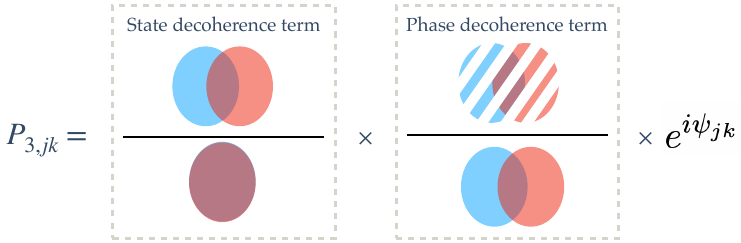
Figure 8 . Demonstration of how we separate the FTP defined in eq. (3.4) into two terms: the state decoherence term and the phase decoherence term in eq. (3.9) and eq. (3.10) in terms of probability. The blue and red shaded circles represent two different mass eigenstates on the physical layer, and while the state decoherence term represents the separation of the two mass eigenstates, the phase decoherence term demonstrates a phase wash-out